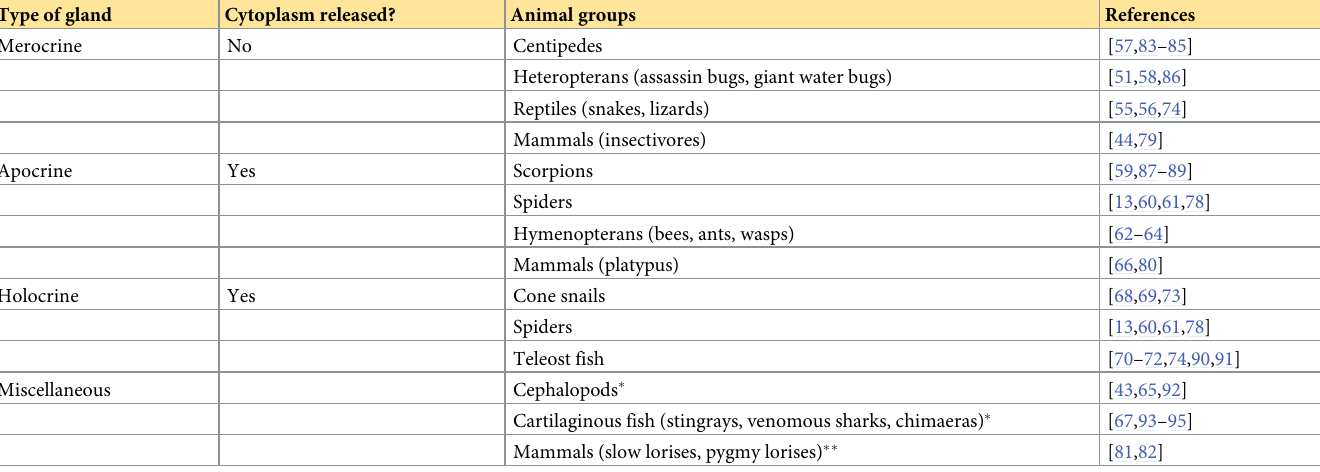
Table 1. Overview of different methods of venom gland secretion across all venomous